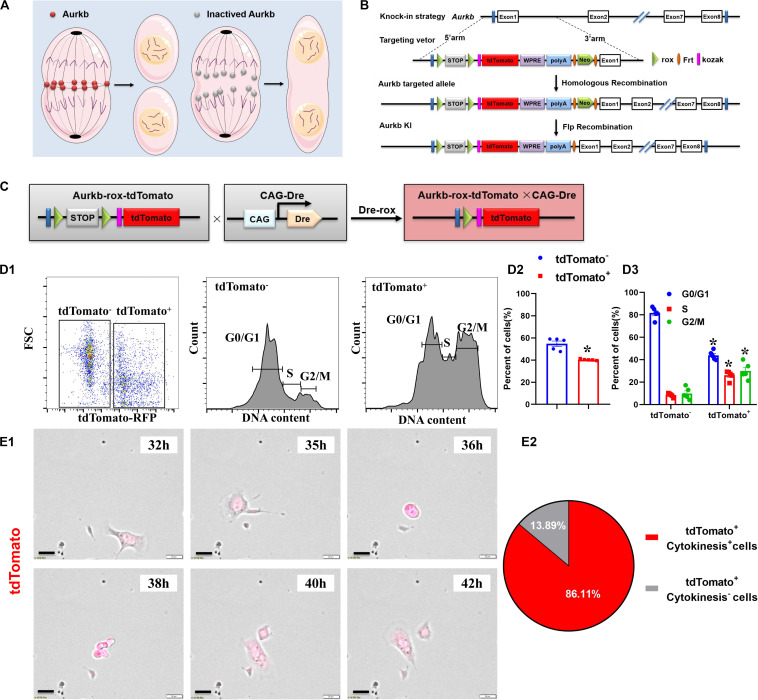
The proliferating cells were efficiently labeled in CAG-Dre × Aurkb-rox-tdTomato neonates. (A) Schematic figure showing Aurkb’s necessity for cell proliferation. (B) Schematic figure showing knock-in strategies for Aurkb-rox-tdTomato alleles by homologous recombination. (C)
CAG-Dre mice were used to cross with Aurkb-rox-tdTomato mice to label all proliferating cells. (D) Representative images of flow cytometry analysis (D1) and quantification of tdTomato± cells (D2) and numbers in G1, S, G2/M phases (D3) from ventricles of P1 CAG-Dre × Aurkb-rox-tdTomato mice. n = 5. *p < 0.05 vs. tdTomato–. (E) Representative images (E1) and quantification (E2) of time-lapse imaging analysis show cell proliferation in vitro of tdTomato+ cells from the ventricles of P1 CAG-Dre × Aurkb-rox-tdTomato mice. Scale bar = 20 μm.